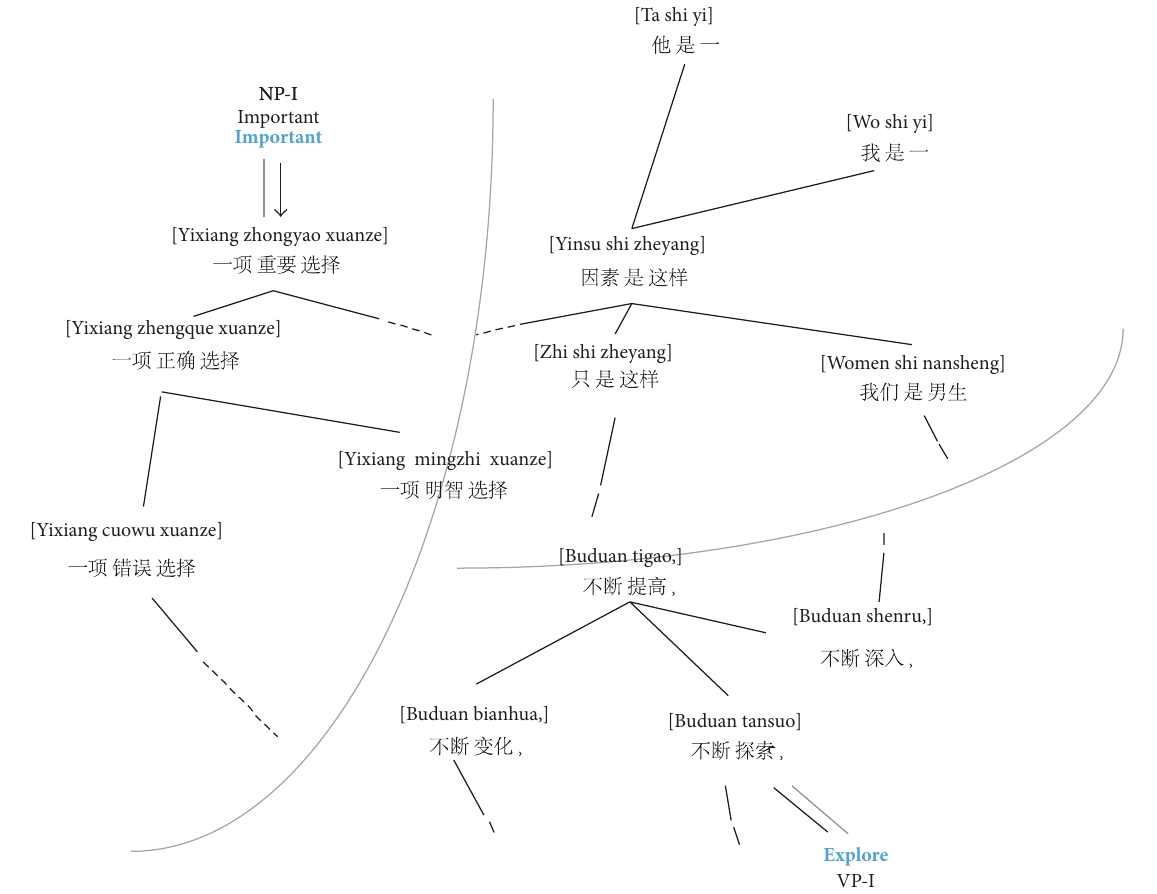
Figure 3: An example of similarity graph over trigram on labeled and unlabeled